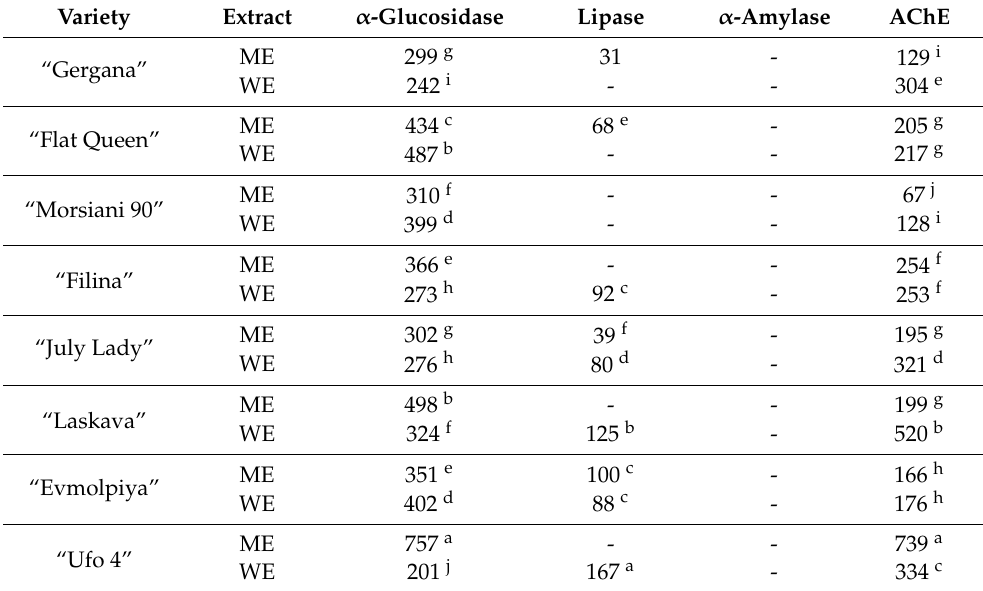
Table 4. Enzyme-inhibitory activities ( α -glucosidase, lipase, α -amylase, and acetylcholinesterase (AChE)) of eight peach varieties’ fruit extracts (methanol (ME) and water (WE)), IC 50 , mg/mL. Variety Extract α -Glucosidase Lipase α -Amylase AChE ME 299 g “Gergana” WE 242 i - - “Flat